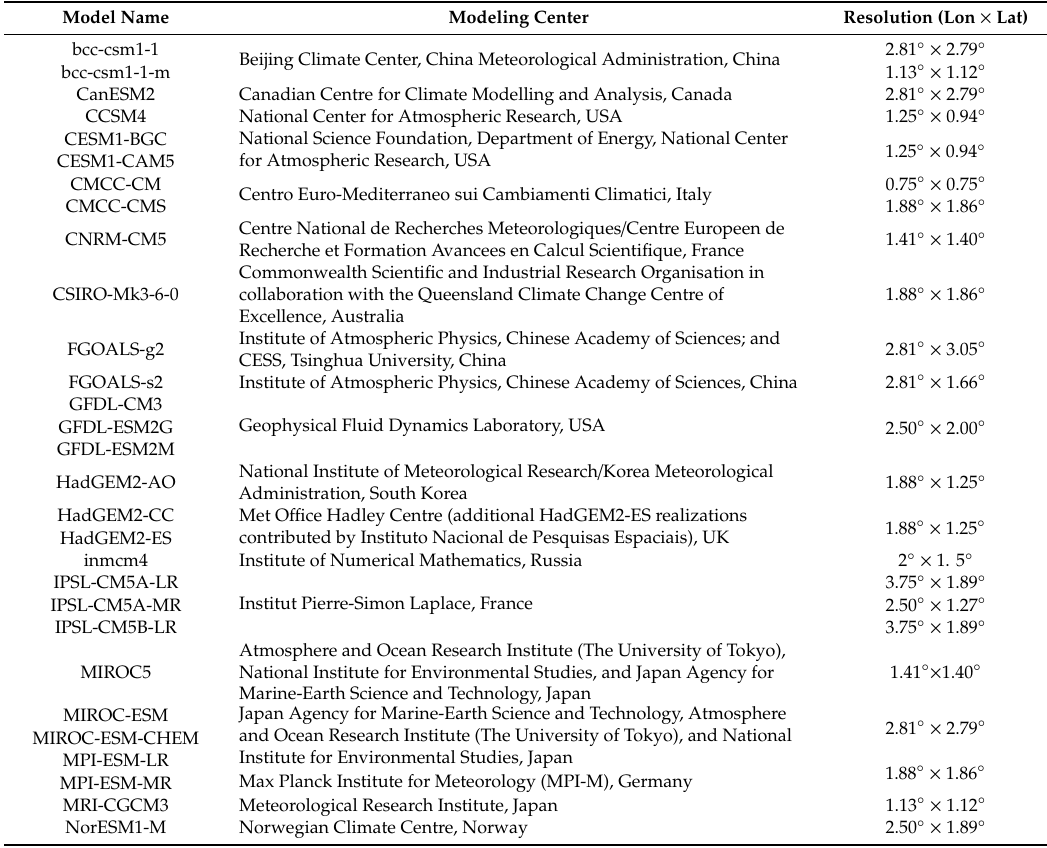
Table 3. Summary of 29 climate models from CMIP5 used in this